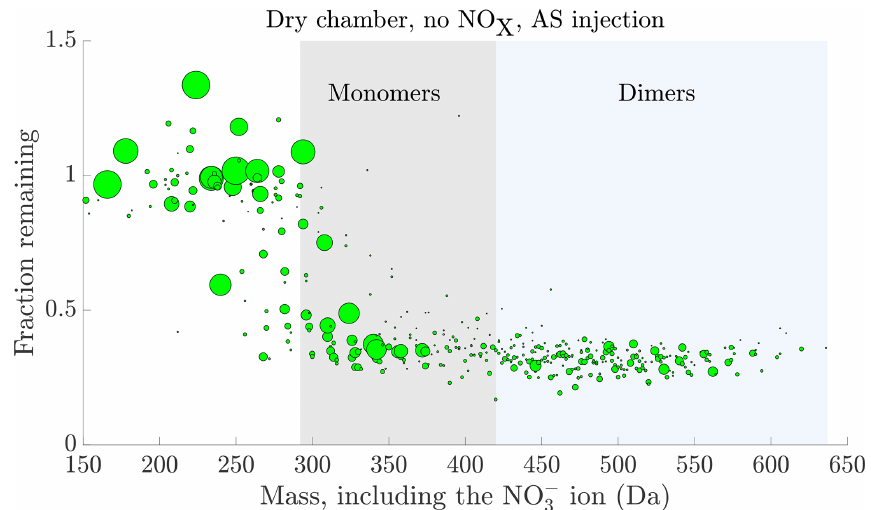
Figure 5. Fraction remaining after seed injection vs. the molecular mass of the detected cluster. The area of the circles has been linearly scaled to the magnitude of the signal of each compound before the seed injection, capped at 3 . 2 × 10 − 3 . The data are the average of experiments 1 and 11, with ammonium sulfate injection, dry chamber and no NO x in the chamber. Compounds with a signal-to-noise ratio, as defined in Sect. 2.7, below 4 have been excluded from the plot. Characteristic HOM monomer and dimer regions have been highlighted with grey and blue shading